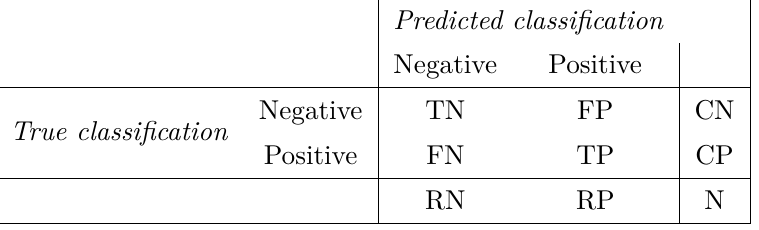
Table 1 . A typical confusion matrix, where TN/FN indicates true negative/false negative, and TP/FP indicates true positive/false positive. CP/CN is the number of events in the posi- tive/negative class, and RP/RN is the number of predicted positive/predicted negative